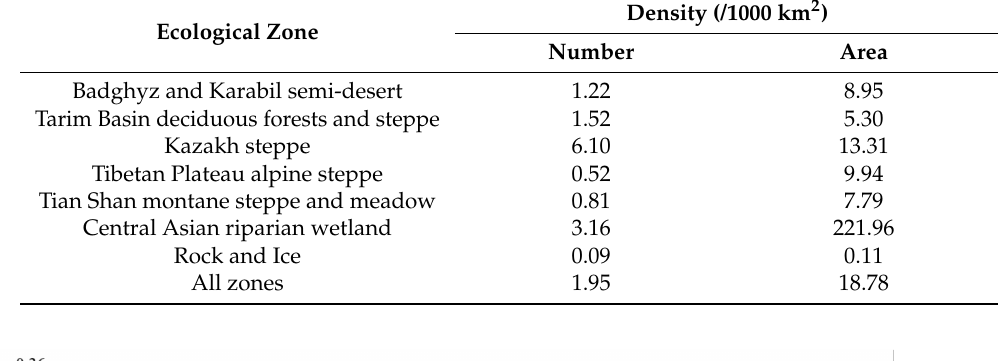
Table 2. The number and area density of lakes on seven terrestrial ecological zones in Central Asia.